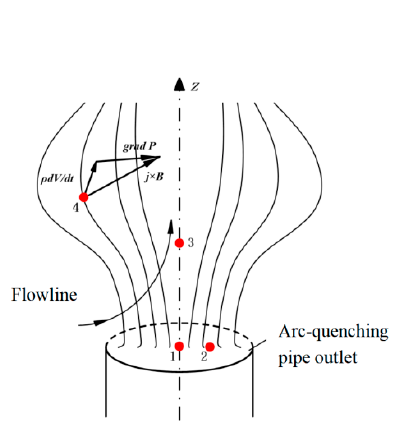
Figure 3. Force analysis diagram of the pipe outlet.